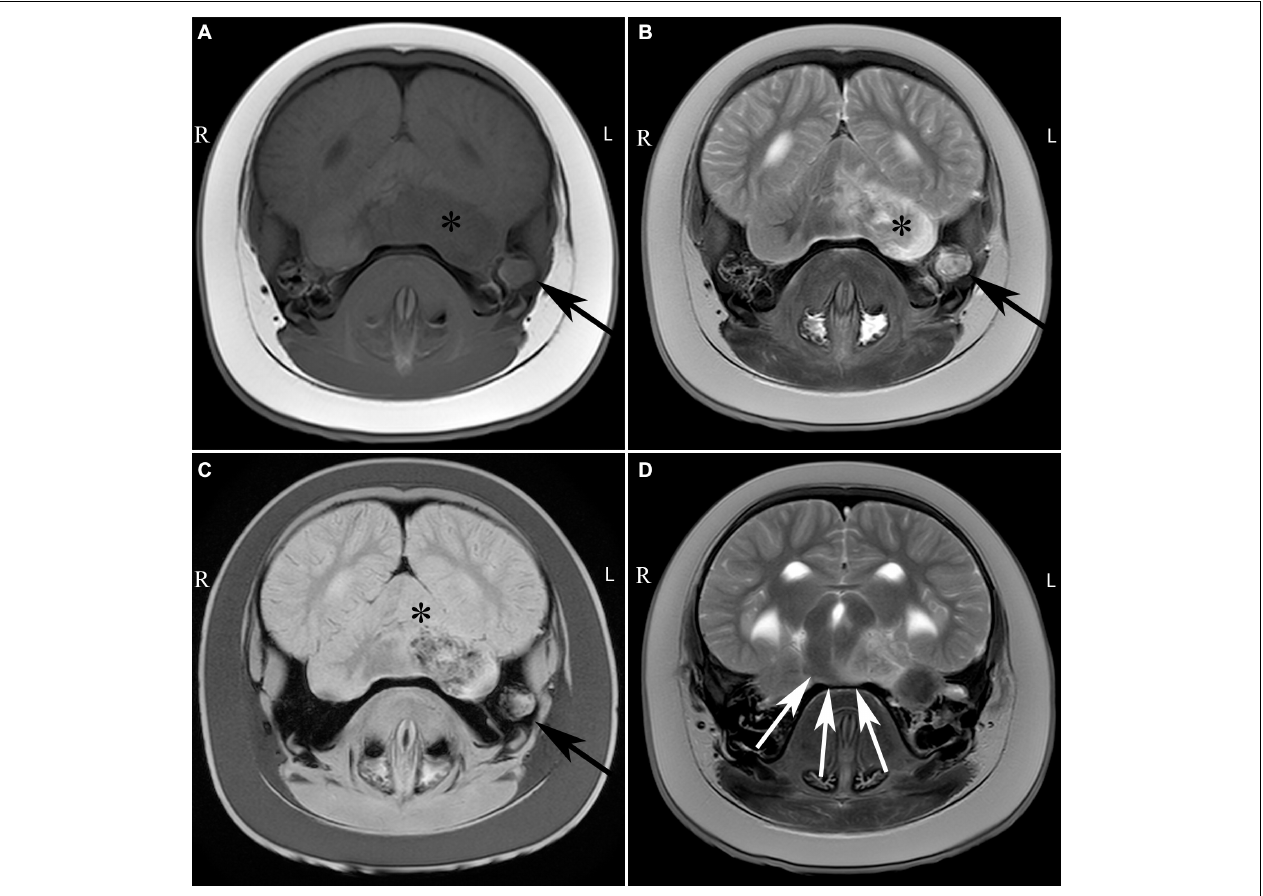
FIGURE 4 | Transverse images of the brain of case #15 at the level of the cerebellum (A–C) and transverse image at the level of the mesencephalon (D) , including T1-weigthed (A) , T2 weighted (B,D) and T2 ∗ weighted (C) images. Large, ill-defined T2 hyperintense lesion affecting the left middle ear (black arrow), brainstem (white arrows), and cerebellum (asterisk) with T2 ∗ signal voids in the left cerebellar hemisphere. L, left; R,